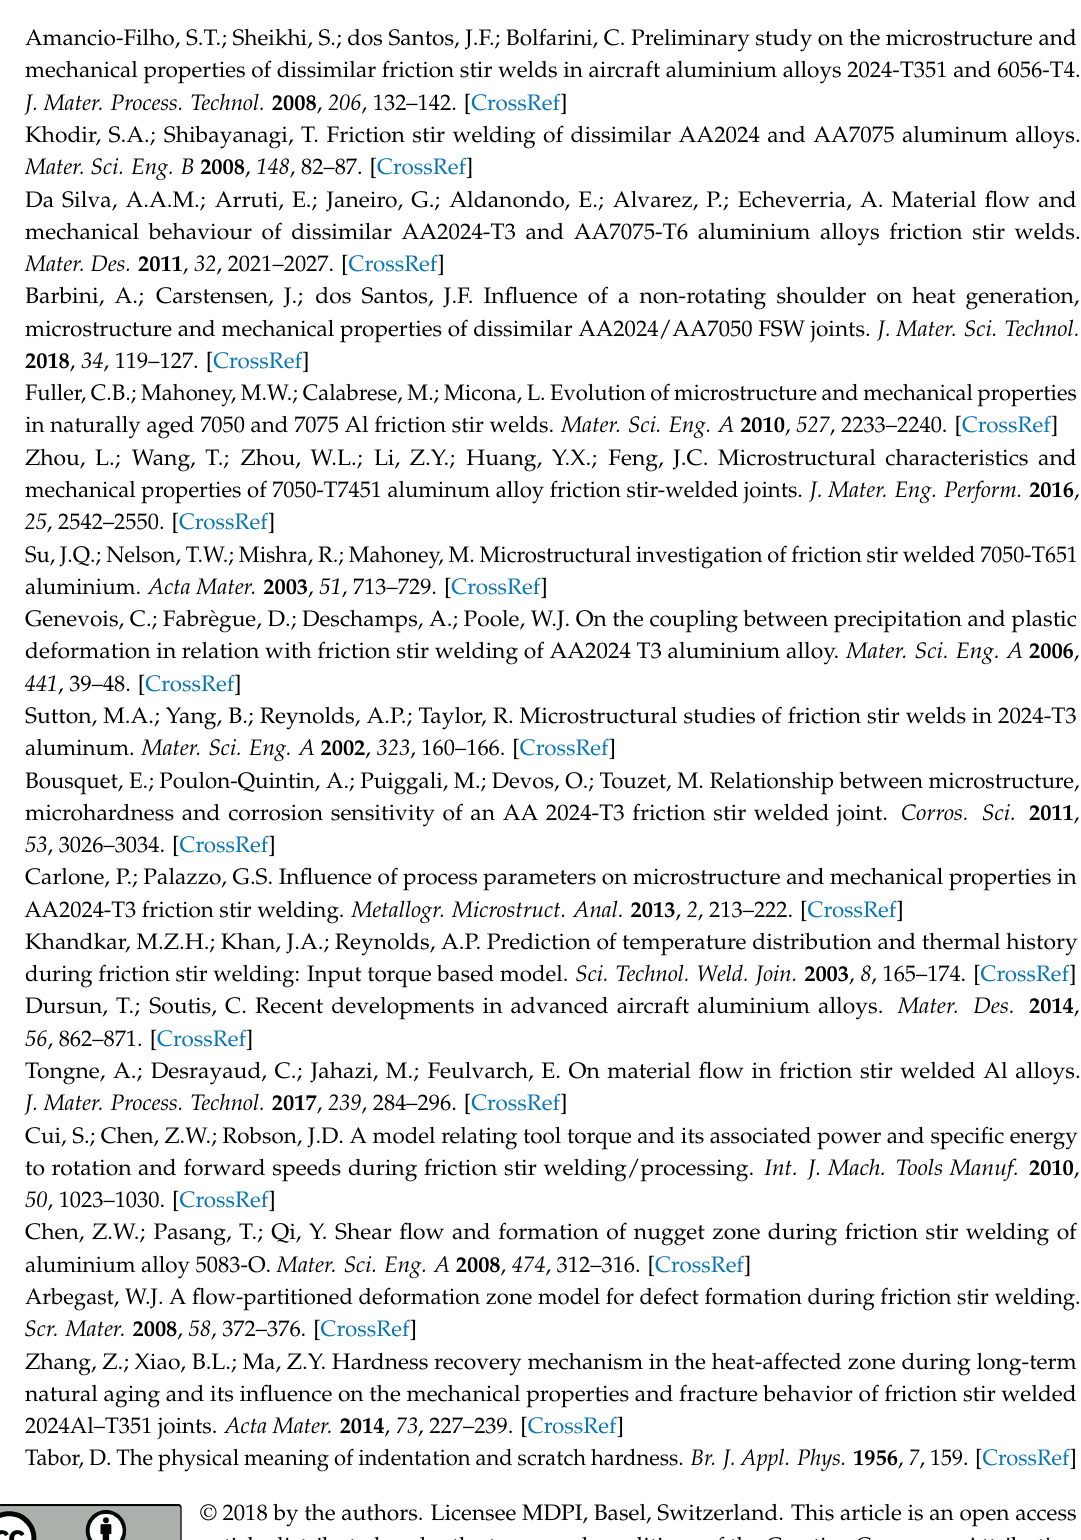
Tabor, D. The physical meaning of indentation and scratch hardness. Br. J. Appl. Phys. 1956 , 7 , 159.